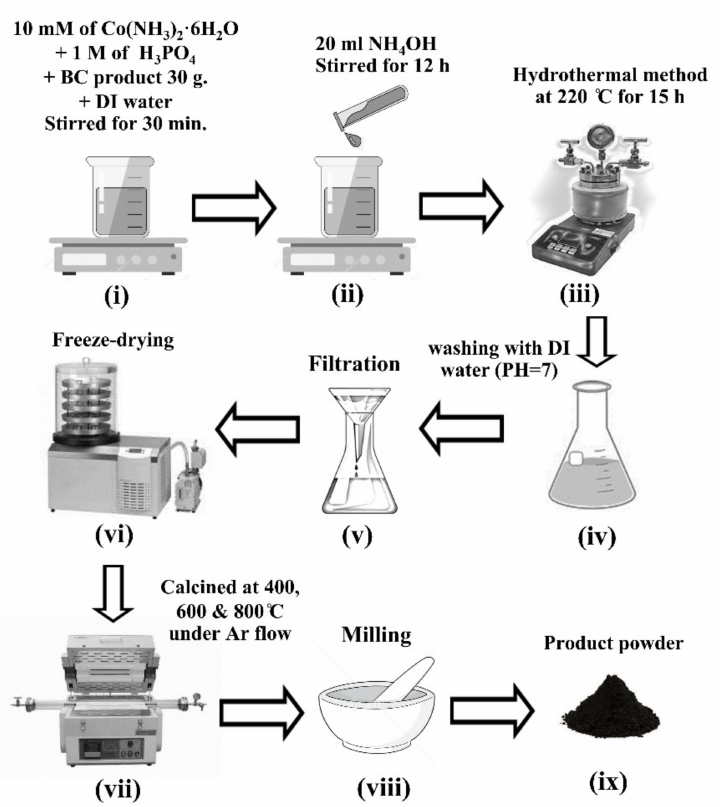
Figure 1. A schematic illustration for the preparation of Co 2 P 2 O 7 /CNFs composite fabrication ( i ) Stoichiometric amounts of raw materials, ( ii ) Adding NH 4 OH, ( iii ) Hydrothermal process, ( iv ) Washing, ( v ) Filtration, ( vi ) Freeze–drying, ( vii ) Calcination, ( viii ) Milling and ( ix ) Product